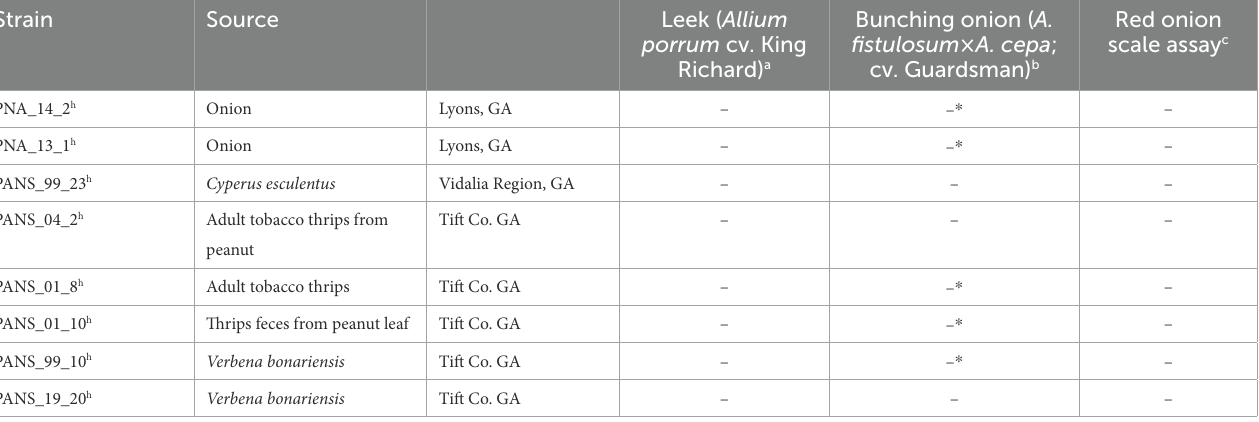
a Foliar lesion rating of P. ananatis strains on Leek ( A. porrum cv. King Richard). Strains with a lesion length 0.2–0.5 cm, 0.5–0.96 cm and > 1 cm were considered as less aggressive (+), moderately aggressive (++), and highly aggressive (+++), respectively. b Foliar lesion rating of P. ananatis strains on bunching onion ( A. fistulosum × A. cepa cv. Guardsman). Strains with lesion lengths of < 0.7 cm, 0.7–1.4 cm and > 1.4 cm were regarded as less aggressive ( + ), moderately aggressive ( ++ ), and highly aggressive ( +++ ), respectively. c Ability of strain to clear red anthocyanin pigment and cause pitting on onion scales. d Strains that are highly aggressive on leeks but non-pathogenic on bunching onion. e Strains that are highly aggressive on leeks and bunching onions and are able to cause necrosis on red-onion scale. f Strains that are non-pathogenic on leeks and less-aggressive on bunching onion. g Strains that are moderately aggressive on leeks, and are less-aggressive on bunching onions. h Non-pathogenic strains. * Lesion phenotype was inconsistent among the six replicates.